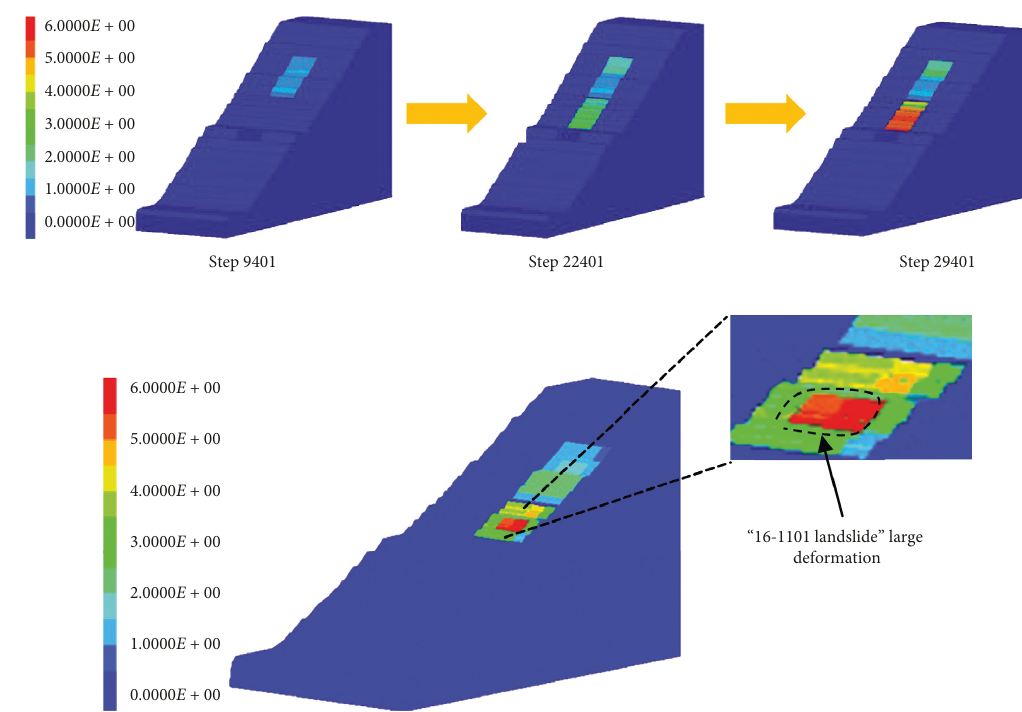
Figure 25: 16-1101 landslide instability displacement contour. Table 6: Criteria of strength degradation